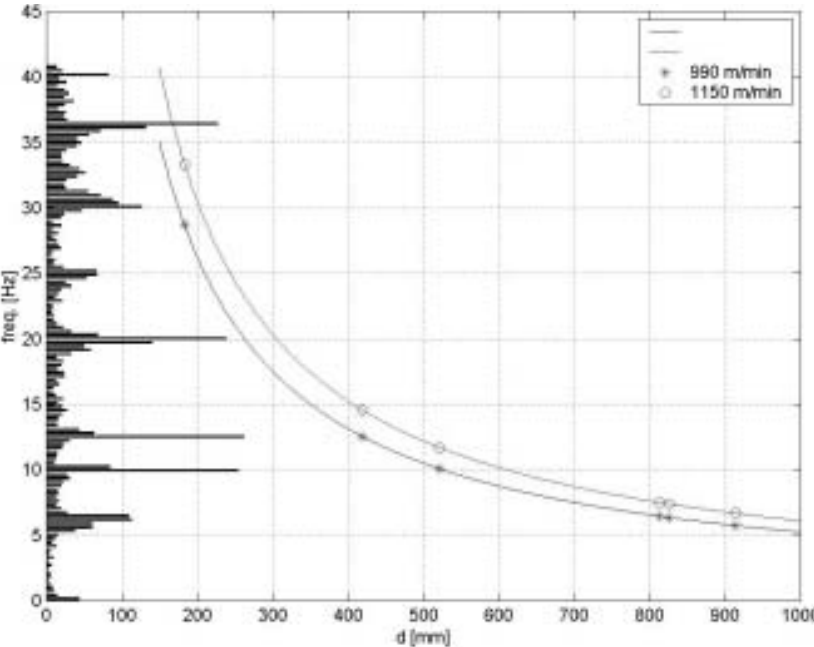
Fig. 12. CVA on the six-channel signal: on the left is shown the occurrence histogram of the extracted frequencies at the current velocity of the paper strip [990 m/1’]. Asterisks and circles denote respectively the unbalances at the current velocity and at the future velocity [1150 m/1’], d indicating the diameter of the cylinders in the machine section under